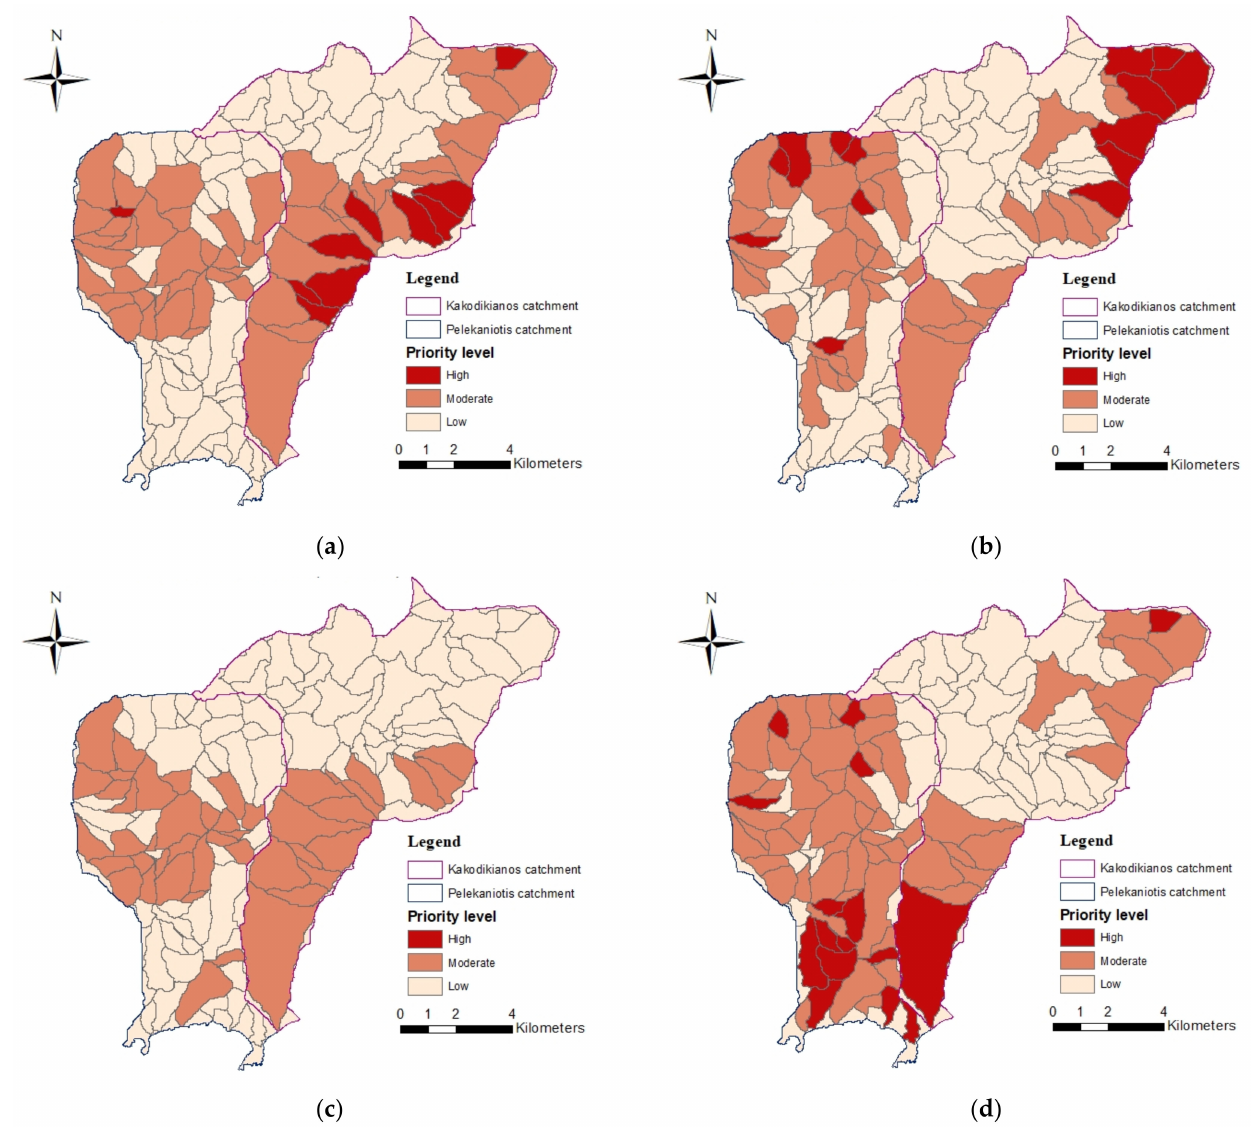
Figure 24. Priority levels of the sub-catchments based on mean soil erosion: ( a ) scenario 1; ( b ) scenario 2; ( c ) scenario 5; ( d ) scenario